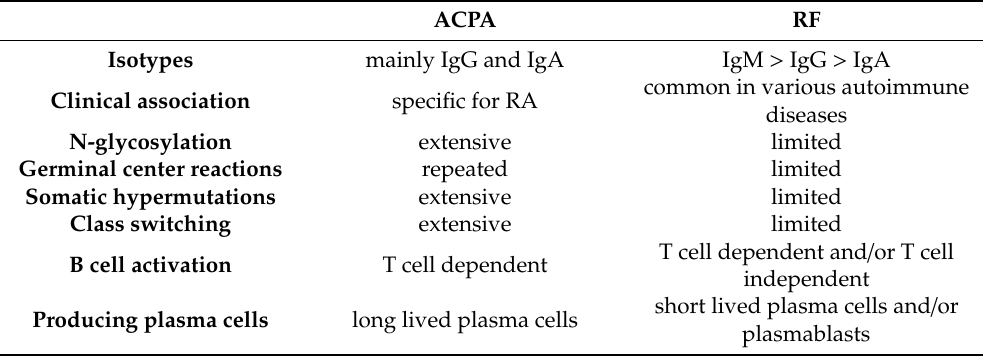
Table 1. The distinct characteristics of ACPA, in comparison with RF